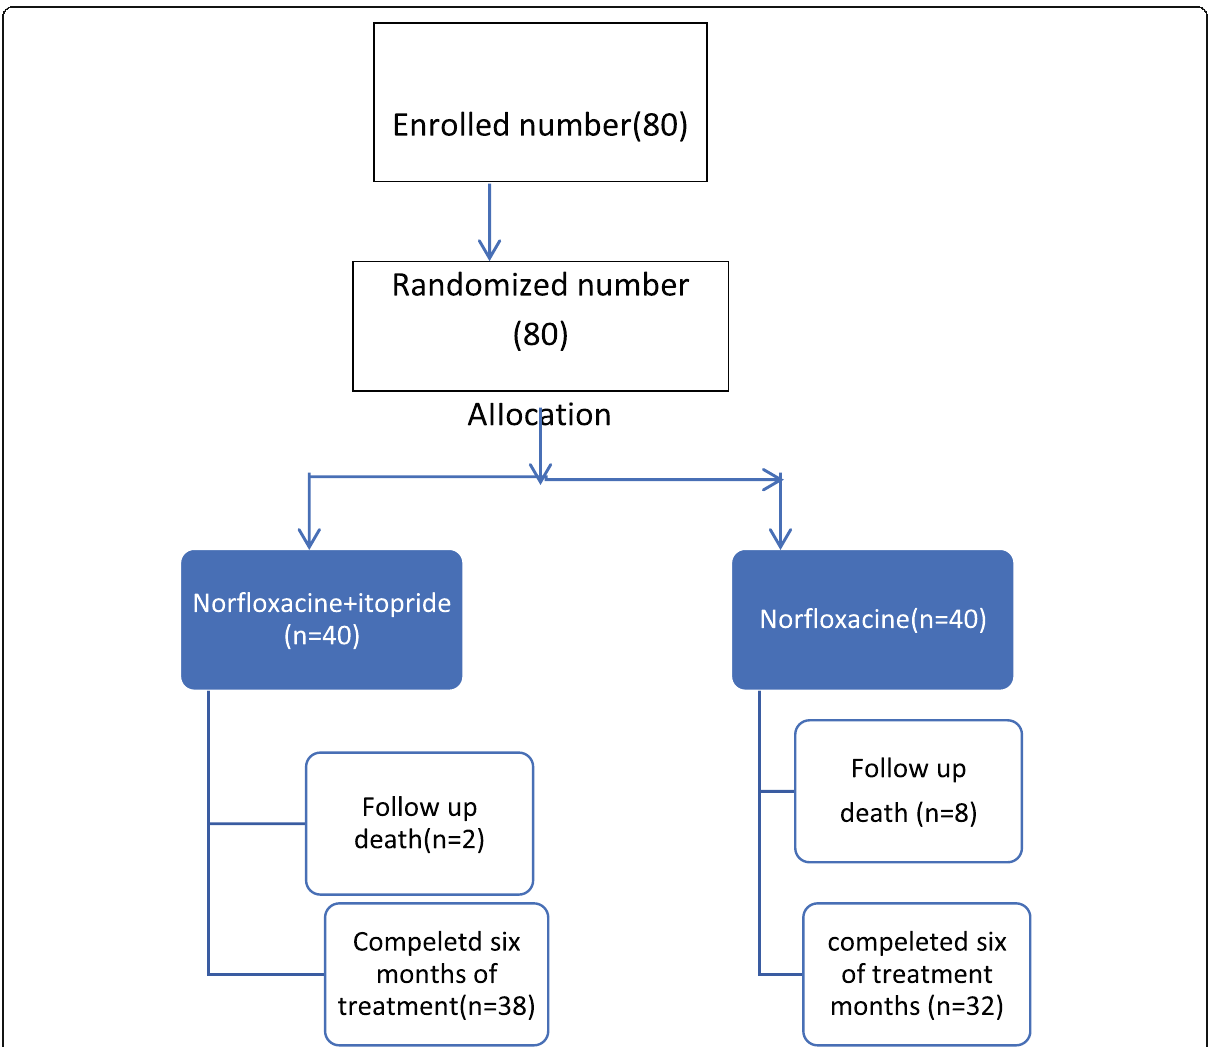
Fig. 1 Flow chart of the study: Flow chart shows Study analysis of cases. n, number of